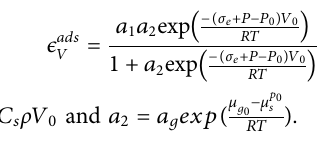
Frontiers in Earth Science |